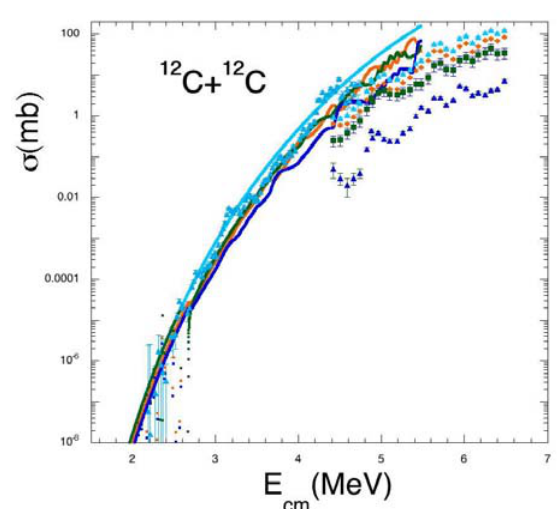
Figure 2 . Fusion cross-section as function symbols) compared to the direct data (full symb total cross section is given by the triangles (cy by the diamonds (orange), n-channel by the circ p-channel (blue) by the squares. The model ag from ref.[8] and it overestimate ref.[7]. No increase of the n-channel (negative Q-value) c p-channel. The model reproduces the trend bu the data of ref.[7].